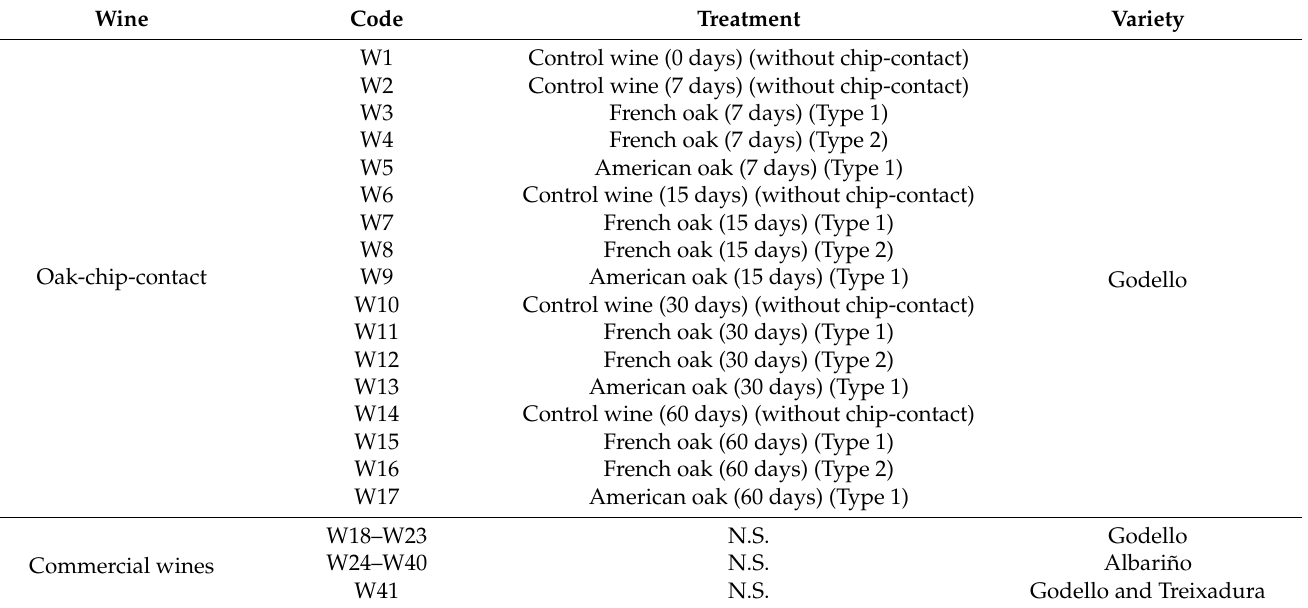
Table 5. Nomenclature and characteristics of white wine